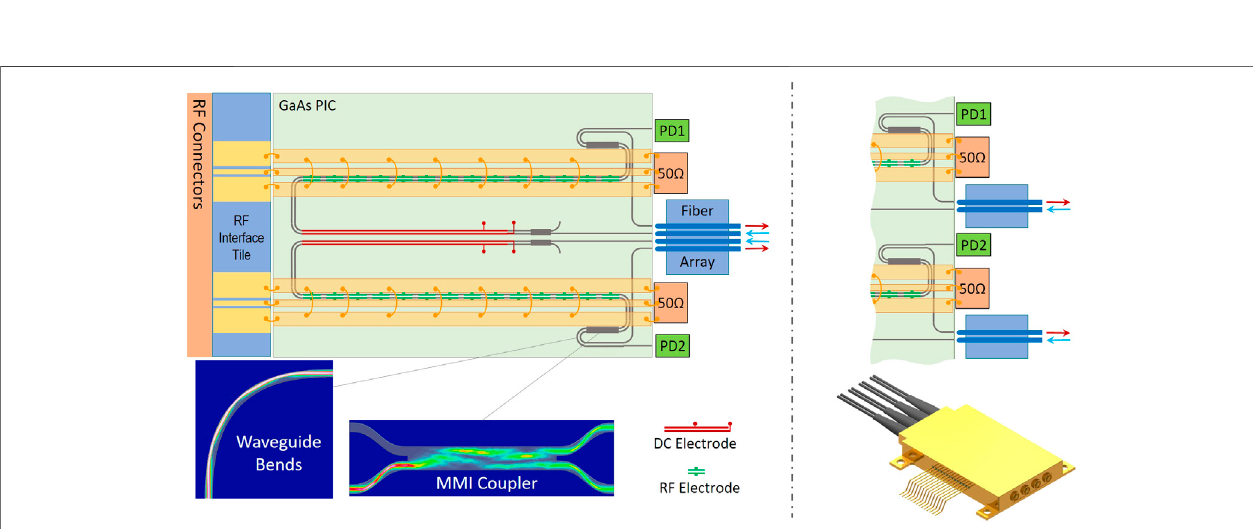
FIGURE3| Folded-pathmodulator arrays (Schematic – not toscale). Left: 2 × 2arrayunit with × 4 fi ber I/O block; Right: Conceptual module withoptical interface detail for 4 × 4 array based on × 2 fi ber I/O